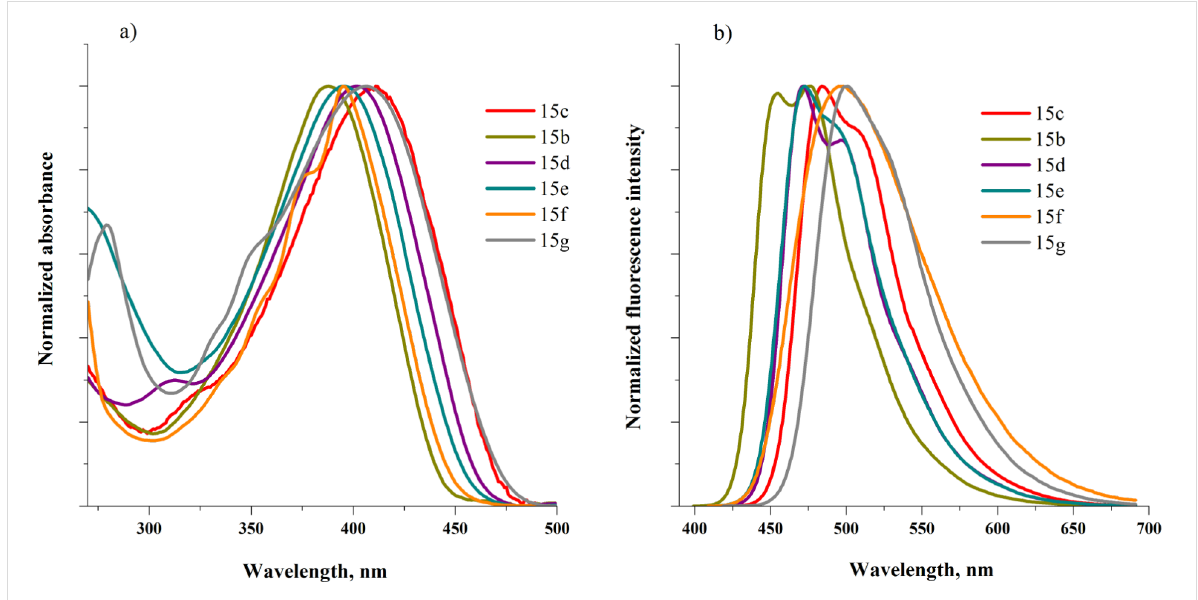
Figure 2: 5'-Aryl-substituted 2,5-bis(3-decyl-2,2'-bithiophen-5-yl)-1,3,4-oxadiazoles 15b – g : a) absorption spectra, b) photoluminescence spectra in DCM.